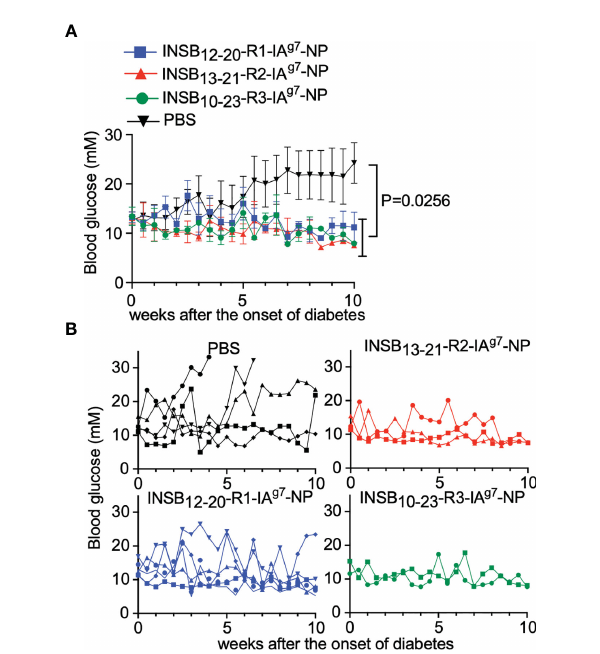
FIGURE 7 Reversal of hyperglycemia by insulin 9-23 /IA g7 -NPs in newly diabetic NOD mice. (A, B) Evolution of average (A) and individual (B) blood glucose levels in diabetic female NOD mice treated with vehicle (n=5) or InsB 12-20 -CT-R1/IA g7 -, InsB 13-21 -R2/IA g7 - or InsB 10-23 -CT- R3/IA g7 -NPs (n=5, 3 and 2, respectively). Data were compared via two-way